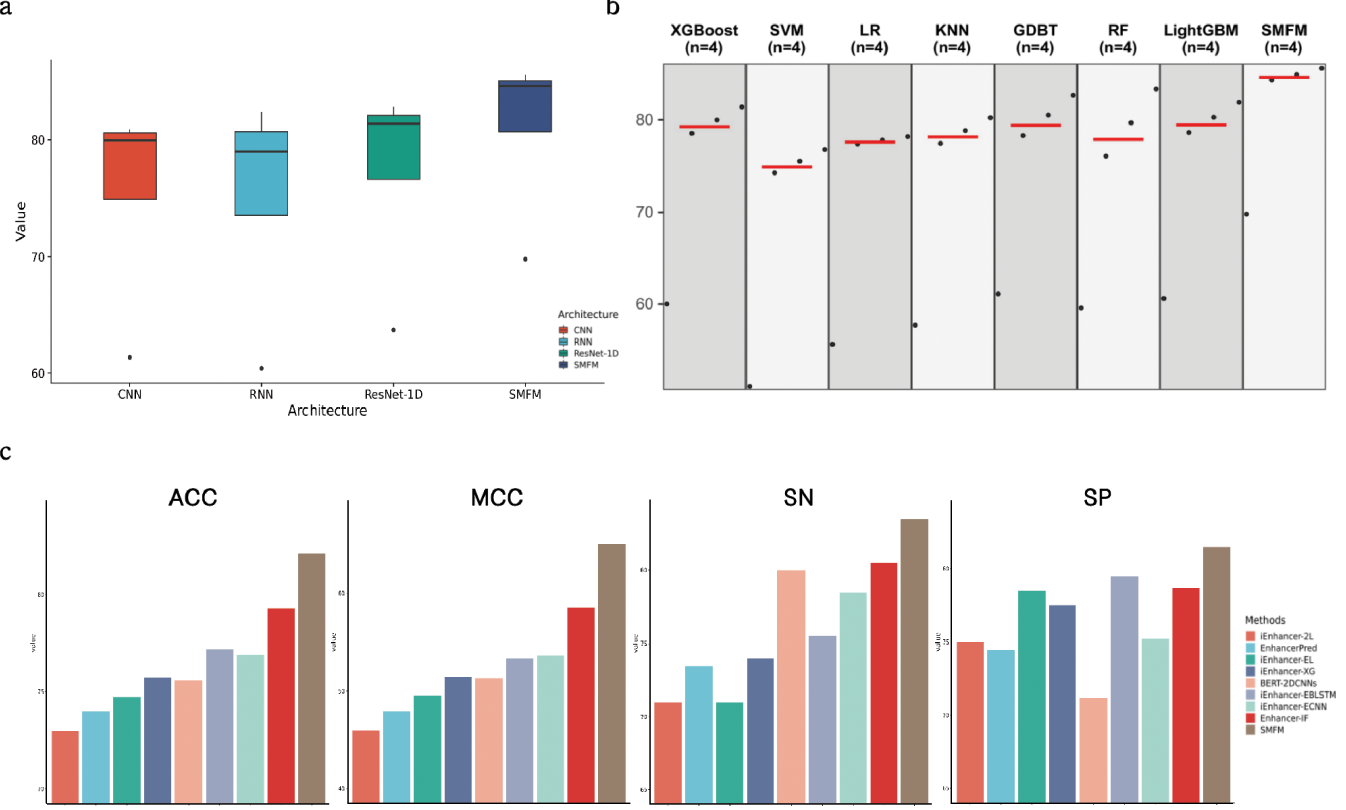
Fig 6. (a) exhibits performance of different deep learning architectures in comparison with SMFM, each box represents four metric values of different architectures; (b) shows performance of different machine learning algorithms in contrast to SMFM, red line shows average value of four metric values of each method; (c) indicating performance of SMFM compared to current state-of-the-art models of enhancer identification on an independent test set, each sub-figure represents comparison result of one of four metrics used in